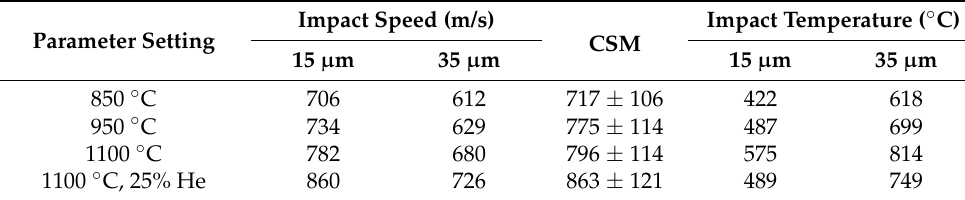
Table 3. Impact temperature and velocity of the AISI 316L particles depending on the coating parame- ters during cold gas spraying. The values were calculated with the KSS software. For the experiments with the cold spray meter, the average particle velocities and standard deviations are listed.